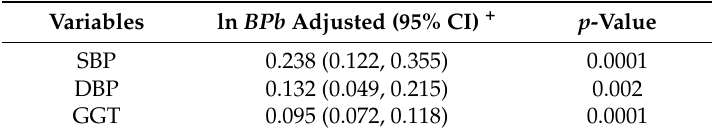
Table 3. Associations between BLLs and cardiovascular-related markers of interest in the U.S. general adult